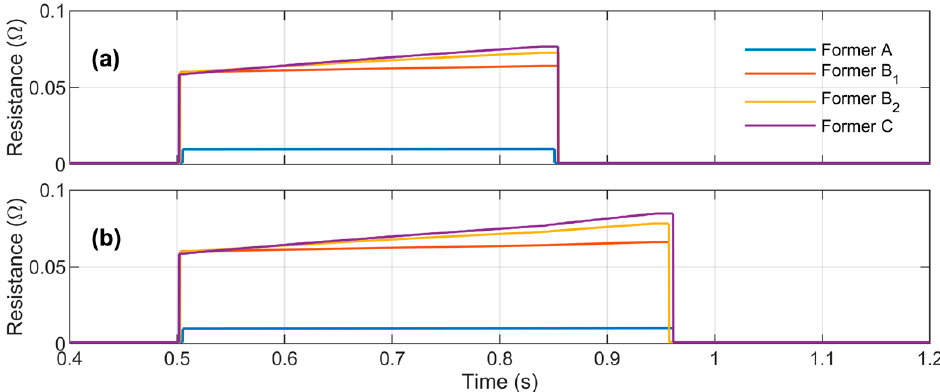
Figure 20. Conducted power in HTS cables in case DCR fails.